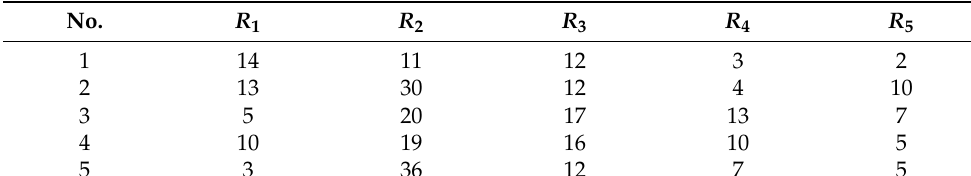
Figure 3. BPAs of each dataset as evidence.